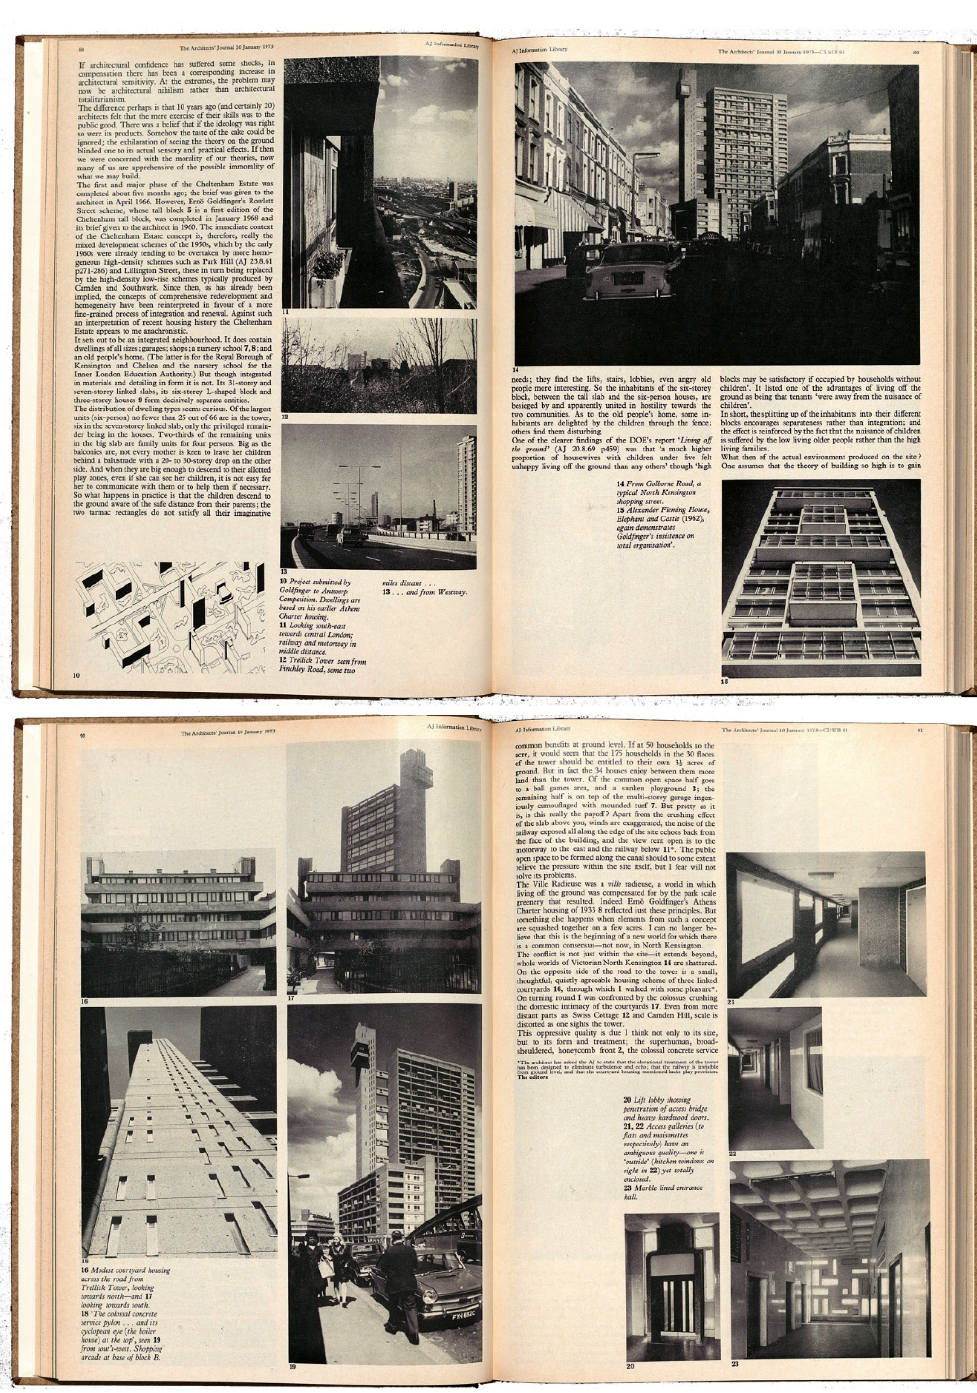
Figure 13. Richardson M. (1973). Cheltenham Estate housing, Architects’ Journal , 157